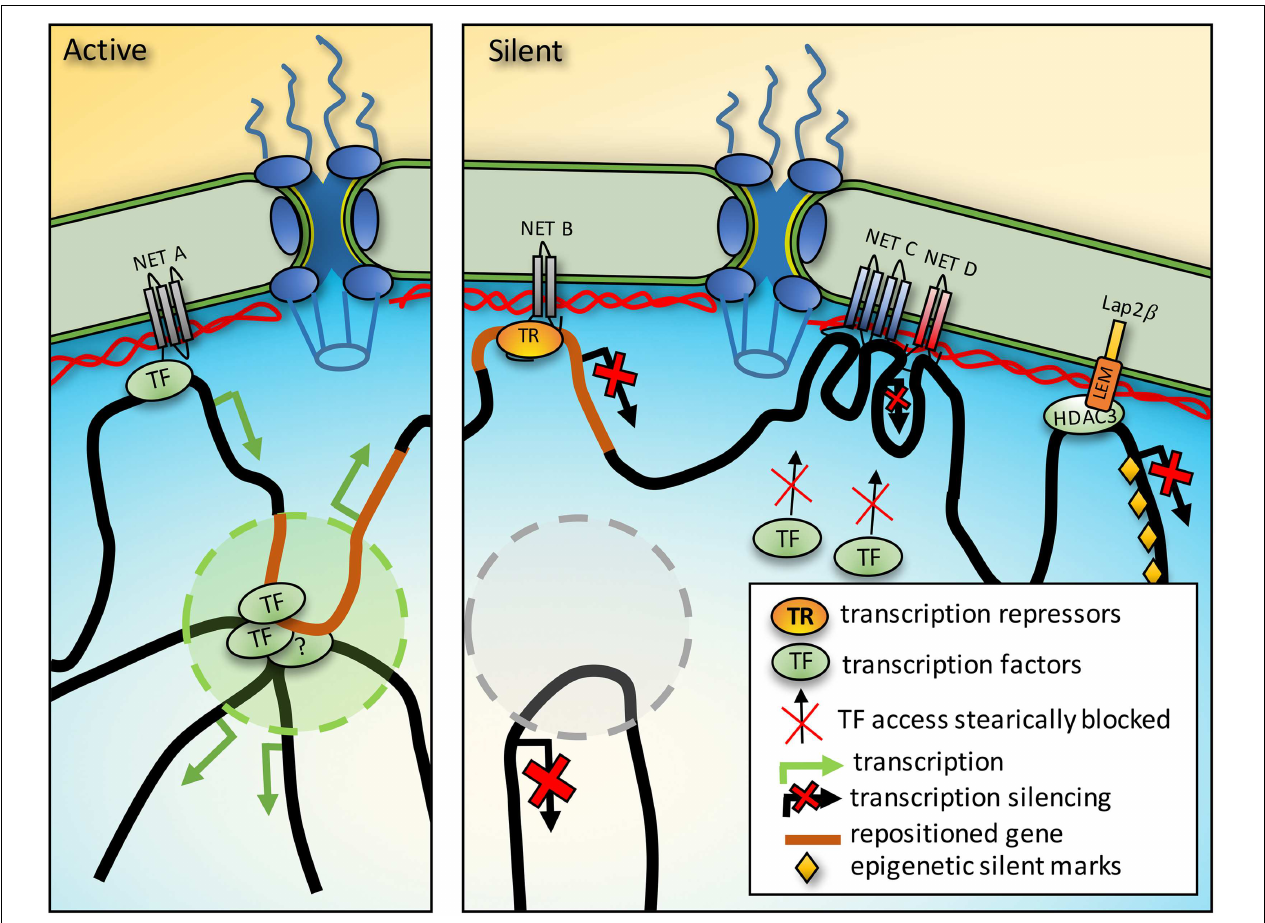
FIGURE 2 | Mechanisms of gene regulation from the nuclear periphery. Activation. NET binding to transcription factors (TF) could promote activation of a gene also sequestered to the periphery. Furthermore, genes between chromatin anchoring points could be directed into TADs where for example the presence of a distal enhancer could strengthen expression. Silencing. In a different cell type the same region that was activating in a TAD could be recruited to the periphery to prevent the enhancer interaction and silence it. Just as TFs could be concentrated at the periphery by NET binding, so could transcriptional repressors (TR). Densities from protein complexes around genes tethered at the NE could also prevent access to TFs. Finally, some NETs interact with enzymes that add epigenetic marks and so recruitment of a gene to the periphery could promote the acquisition of silencing